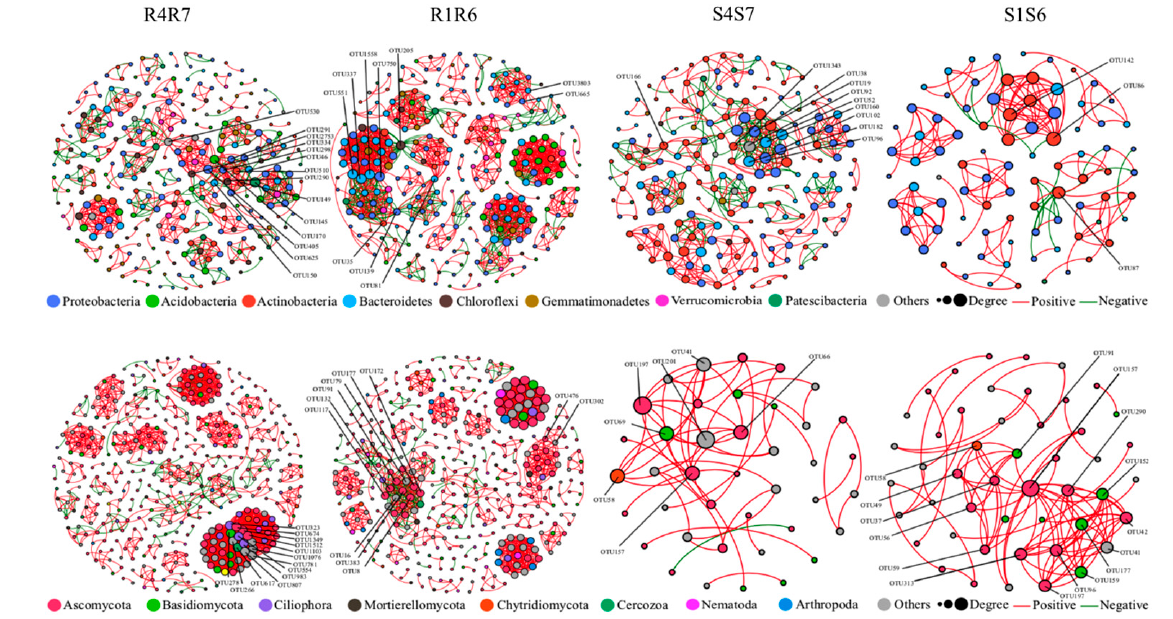
Figure 6. Co-occurrence network of the bacterial and fungal communities of different compartments (S and R indicate root endosphere and rhizosphere, respectively) across the different varieties (1,6 indicate the rot-conducive variety; 4,7 indicate the rot-suppressive variety) and farming modes (1,4 belong to monoculture mode; 6,7 belong to rotation mode).